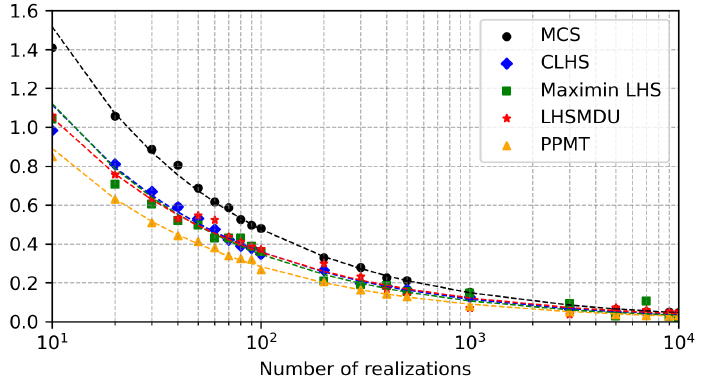
Figure 11. The averages of the e values versus the number of realizations generated by each sampling technique considering that the OOIP variables are correlated.